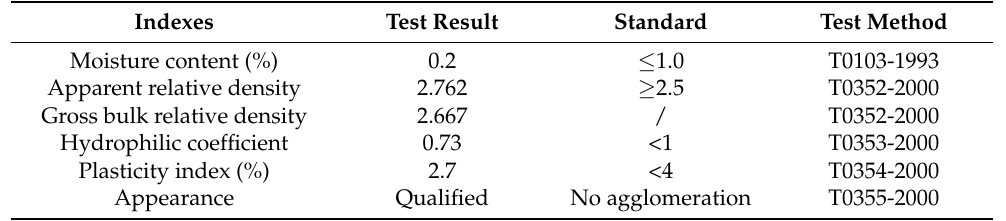
Table 3. Basic properties of limestone